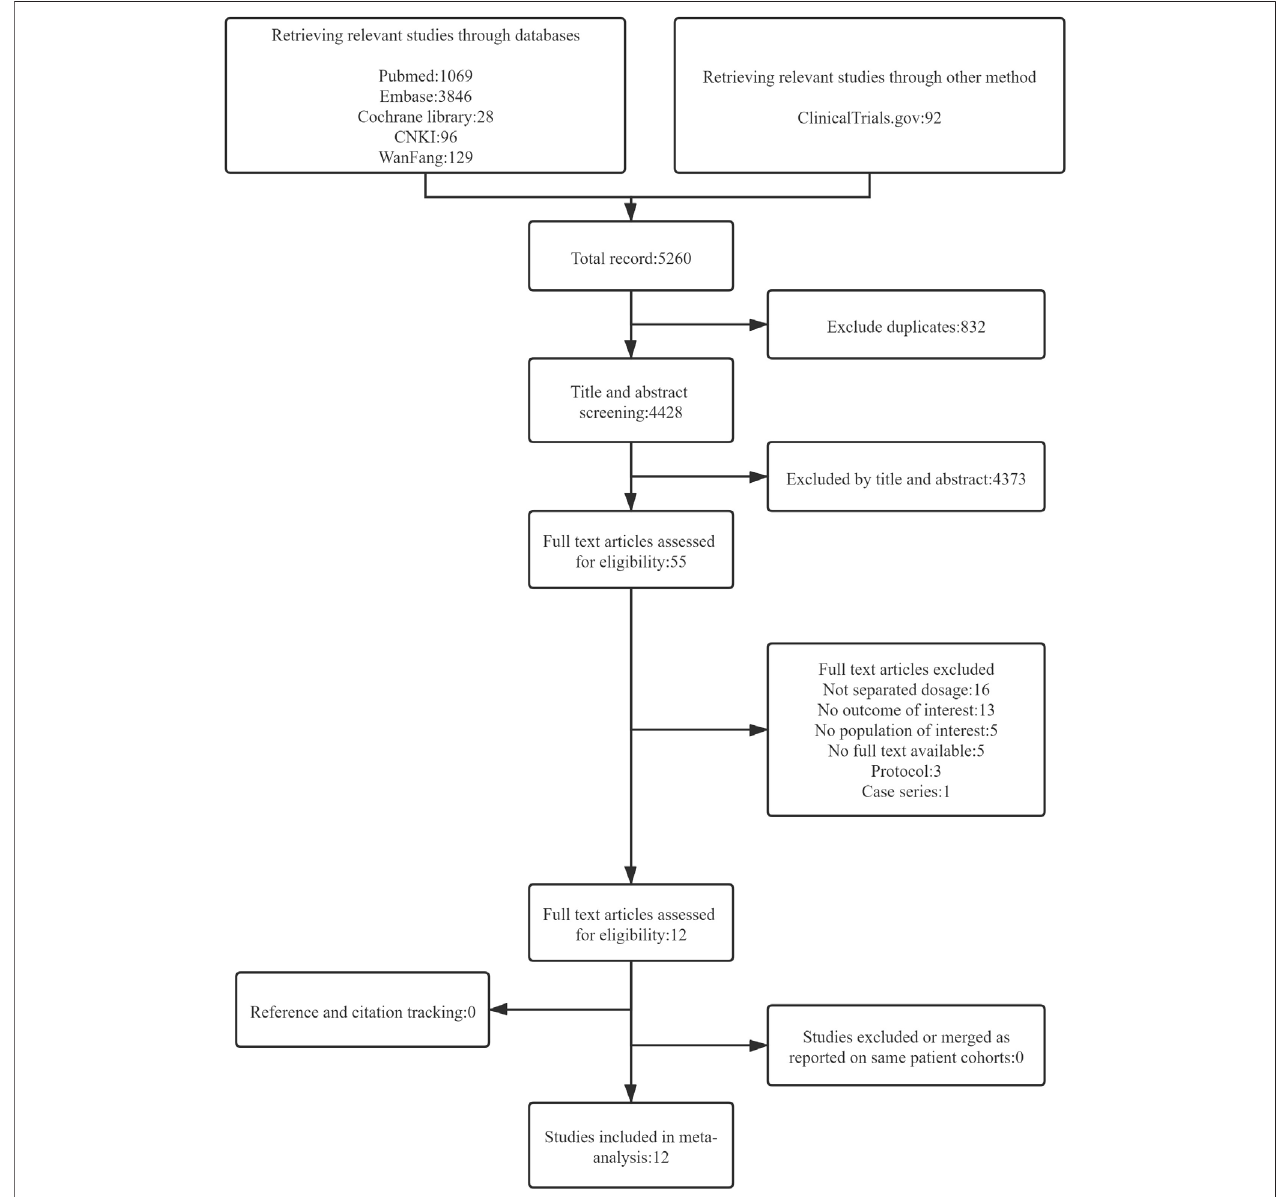
FIGURE 1 | Flow diagram representing search and selection of studies comparing 30 versus 40 mg of afatinib treatment in patients with EGFR-mutant NSCLC.